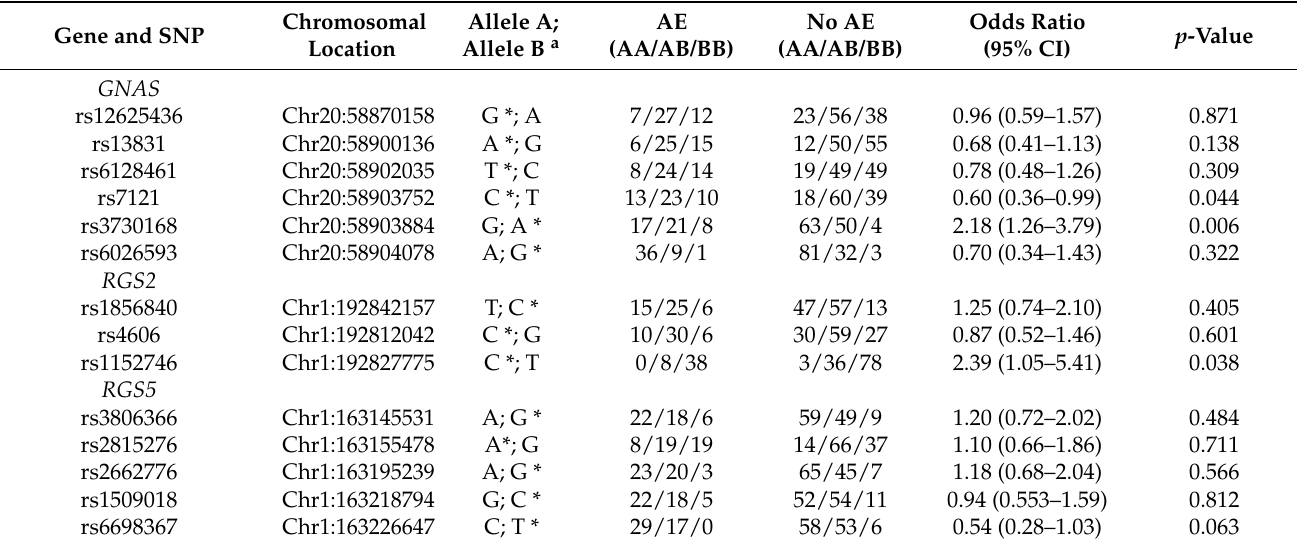
Table 2. Effects of genotypes on ritodrine-induced adverse events.